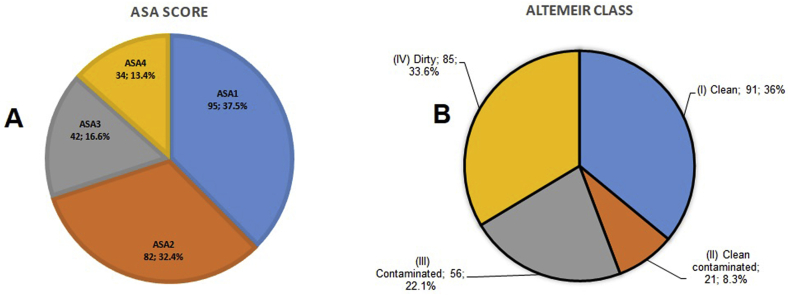
ASA score & altemeir class.